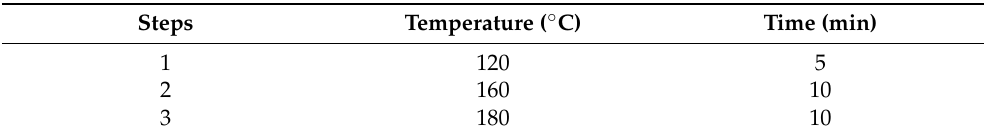
Table 1. Working conditions of microwave digestion instrument.